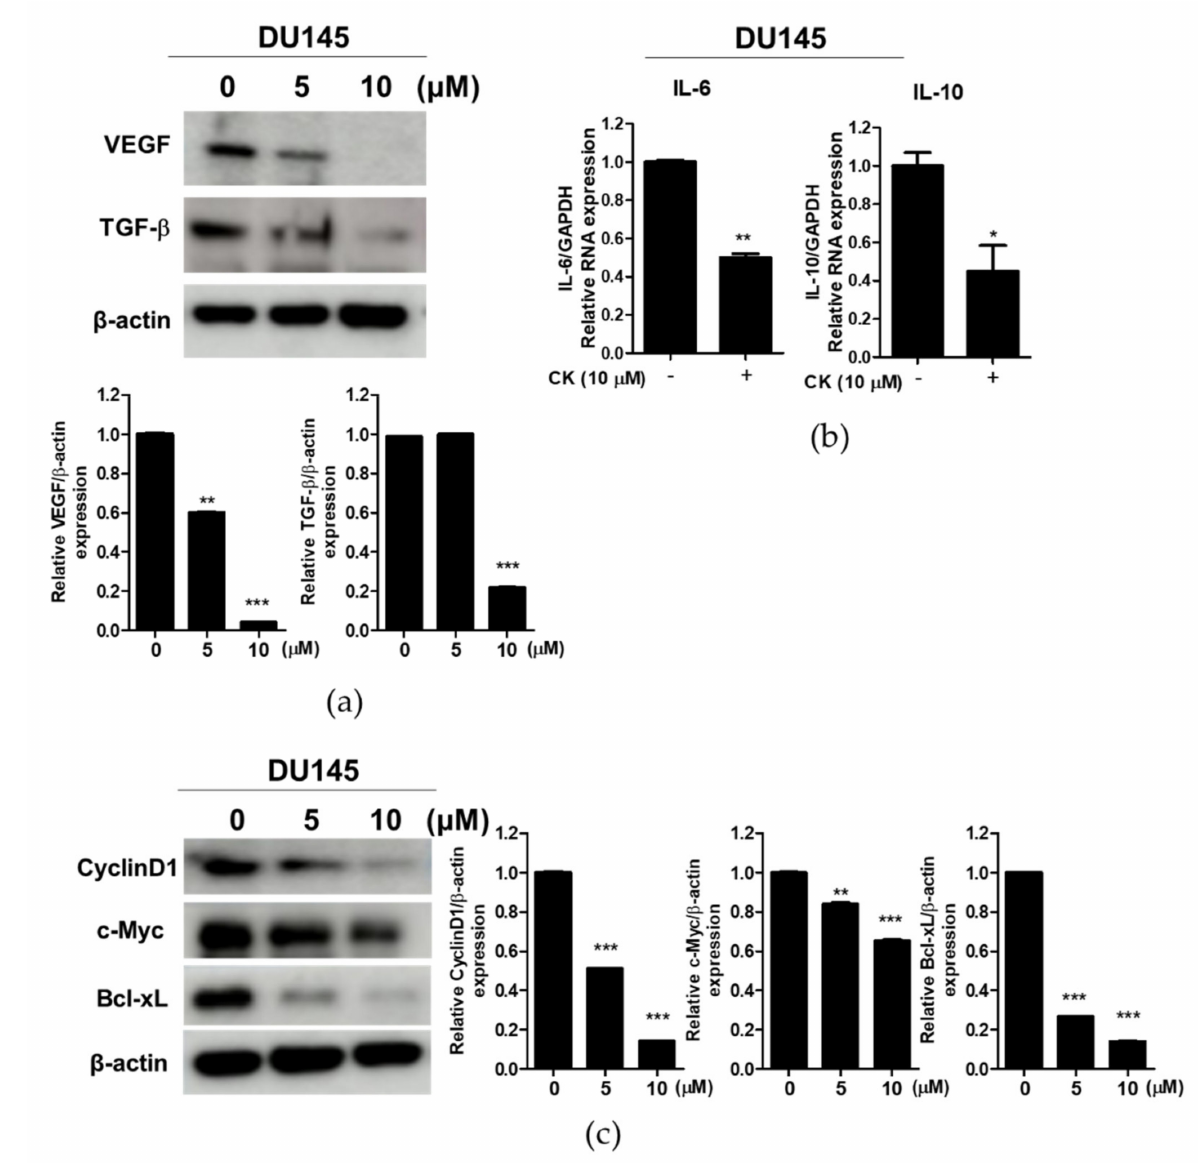
Figure 6. Effect of compound K on immune escape-related proteins and STAT3 target proteins in DU145 cells. ( a ) DU145 cells were treated with CK (0, 5 or 10 µ M) for 24 h. Cell lysates were prepared and subjected to Western blotting for VEGF and TGF- β . ( b ) IL-6 and IL-10 mRNA expression in DU145 cells by qRT-PCR. ( c ) DU145 cells were treated with CK (0, 5 or 10 µ M) for 24 h and subjected to Western blotting for CyclinD1, c-Myc and Bcl-xL. Graphs represent relative levels of protein/ β -actin. Data stand for means ± SD. * p < 0.05, ** p < 0.01 and *** p < 0.001 versus untreated